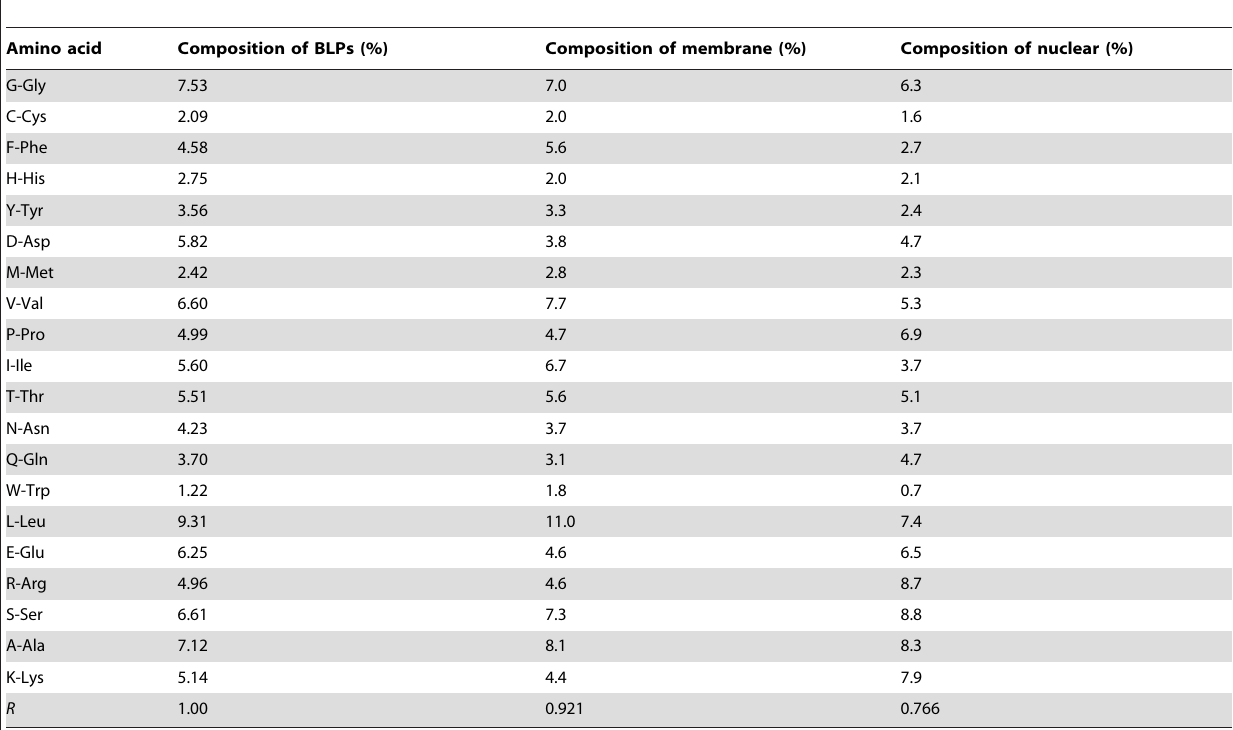
Table 5. The compositions of BLPs, integral membrane proteins, and nuclear proteins, and their corresponding R values using the training dataset